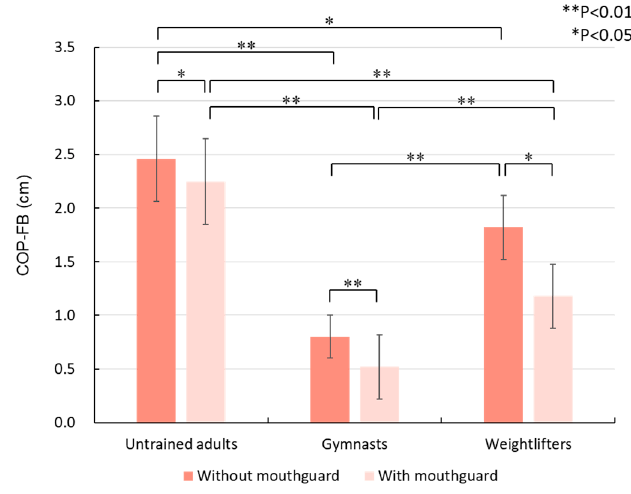
Figure 4. Comparison of center of pressure displacement in the front-and-back direction (COP-FB) among participants by mouthguard condition. Measurements are expressed as means ± SD. The error bar indicates the standard error of the mean. ** p < 0.01, * p < 0.05: denotes statistically significant difference.